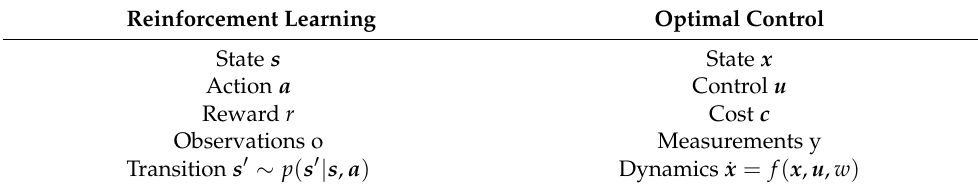
Table 2. Similarities in the notations of reinforcement learning and optimal control. Here the transfer function of reinforcement learning is formulated in discrete time while the dynamics in optimal control are in continuous